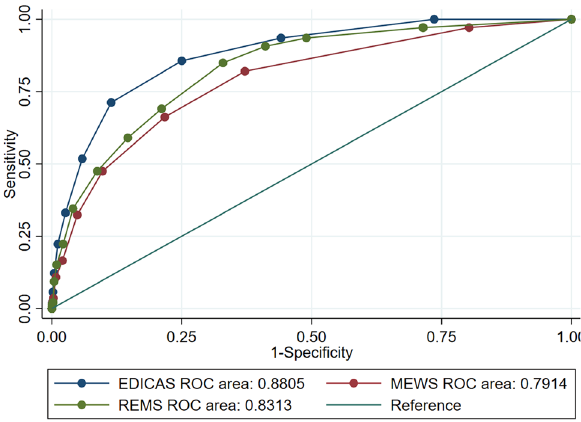
Figure 3. Receiver operating characteristic curves for three early warning scores: EDICAS, MEWS, and REMS. The diagonal line represents a model of no discriminatory ability. EDICAS Emergency Department In-hospital Cardiac Arrest Score, MEWS Modified Early Warning Score, REMS Rapid Emergency Medicine Score.